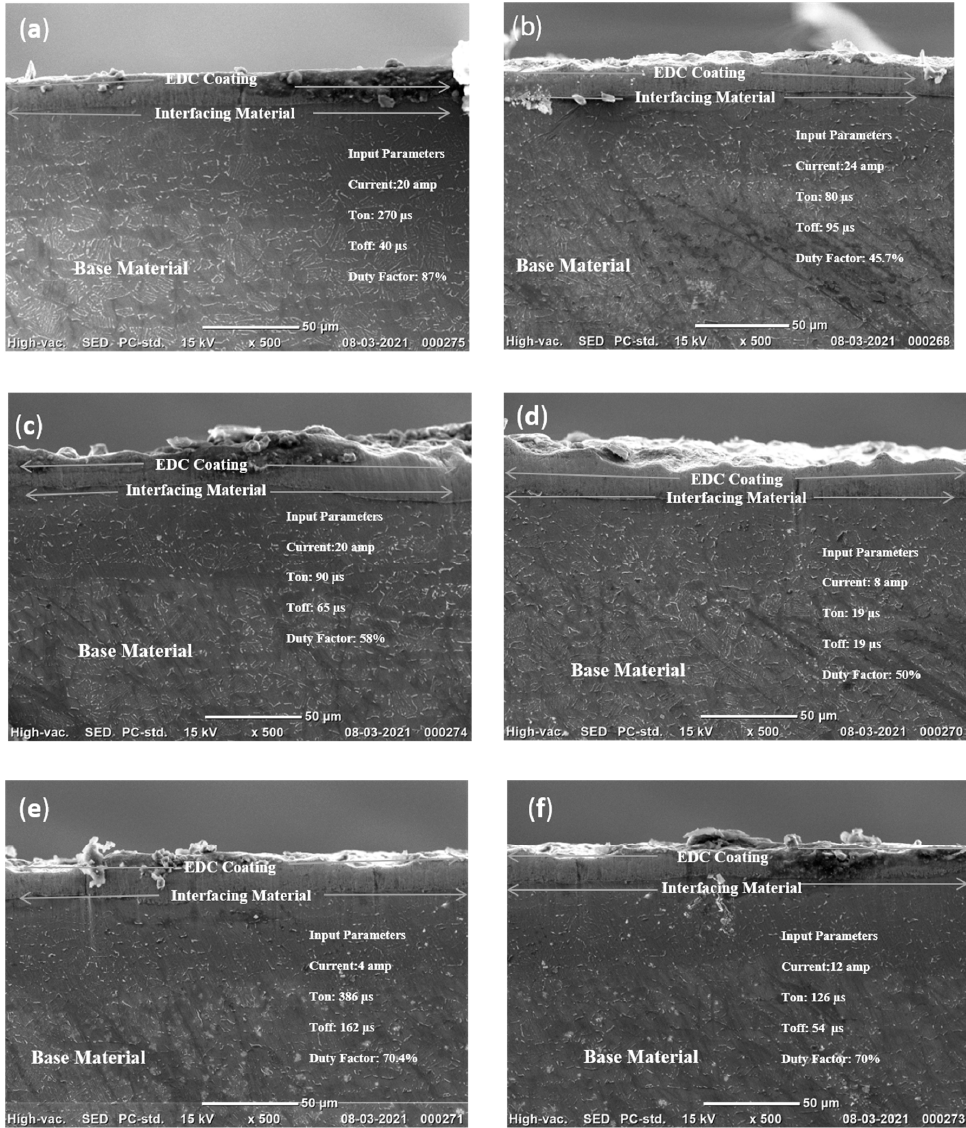
Figure 11. Cross section of material interfacing bonding for six experiments shown in the order of ( a ) to ( f )